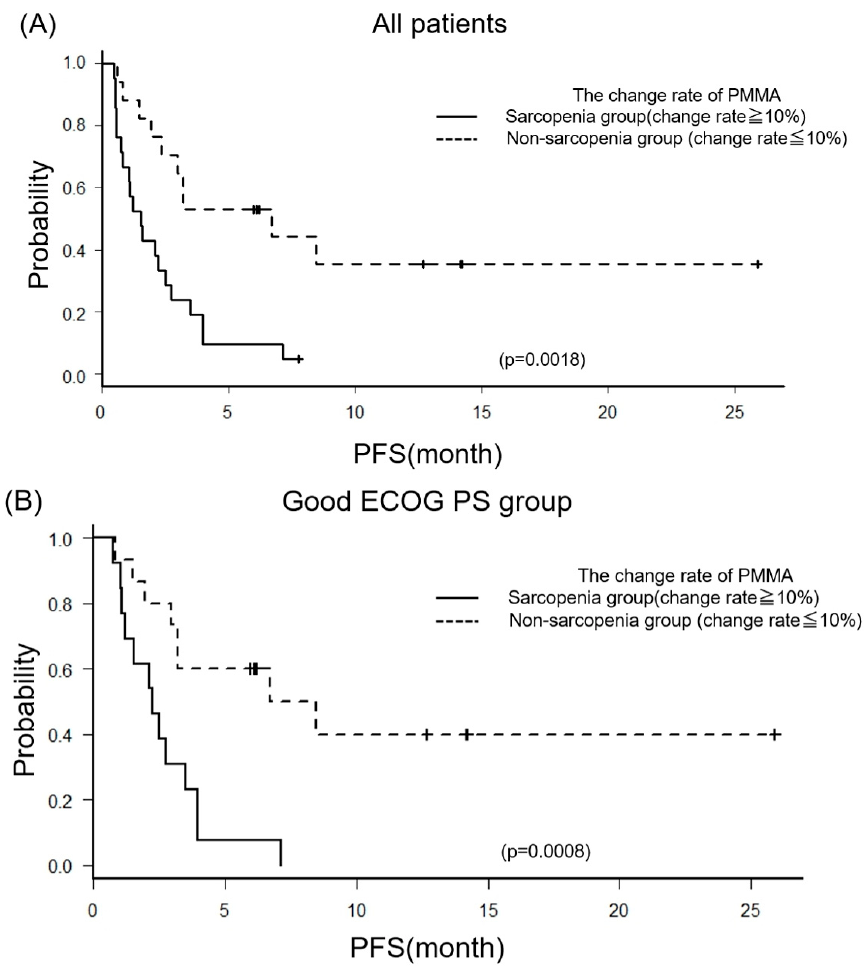
Figure 4. Kaplan–Meier curves of the progression-free survival (PFS). We compared PFS between sarcopenia and non-sarcopenia groups, including all patients ( A ) or focusing on the good PS group ( B